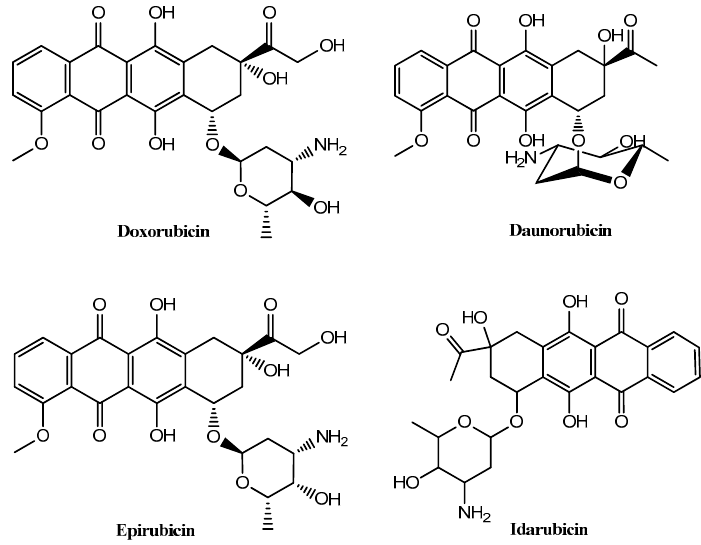
Figure 2. Tetralin including anticancer drugs.